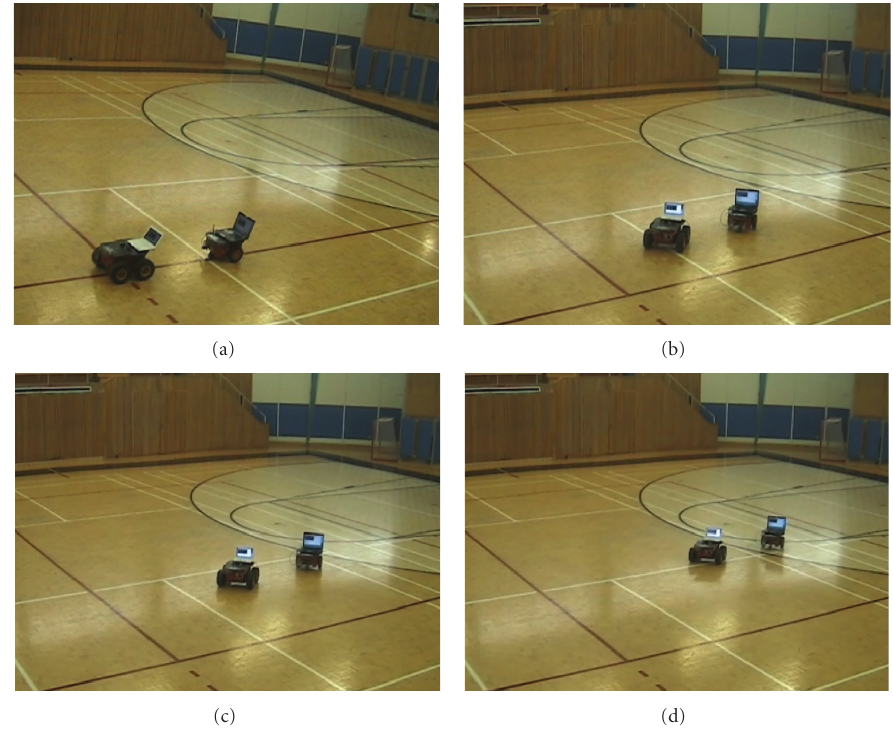
Figure 9: Experimental result of group movement tracking straight line: (a) 0 second; (b) 20 seconds; (c) 40 seconds; (d) 60 seconds.